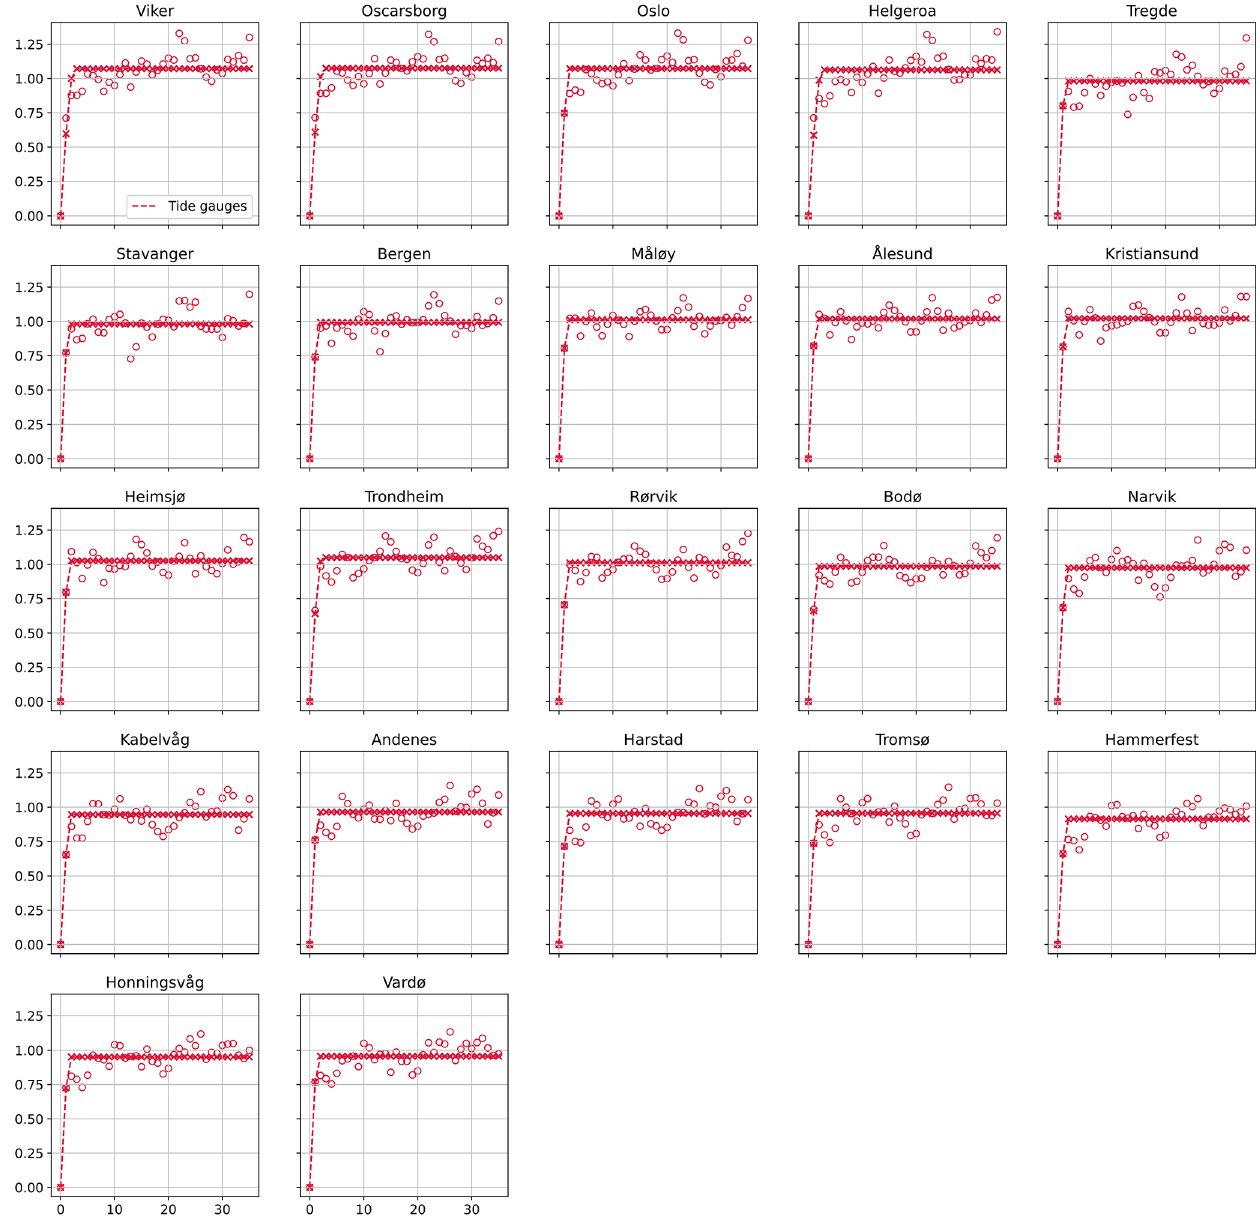
Figure A2. For each tide gauge along the Norwegian coast, semi-variogram of the detrended and deseasoned SLA measured by the tide gauge (empty circles) and corresponding fit (crosses connected by a dashed line). At each tide-gauge location, we scaled each semi-variogram by the variance of the corresponding detrended and deseasoned SLA for all the plots to have the same limits on the y